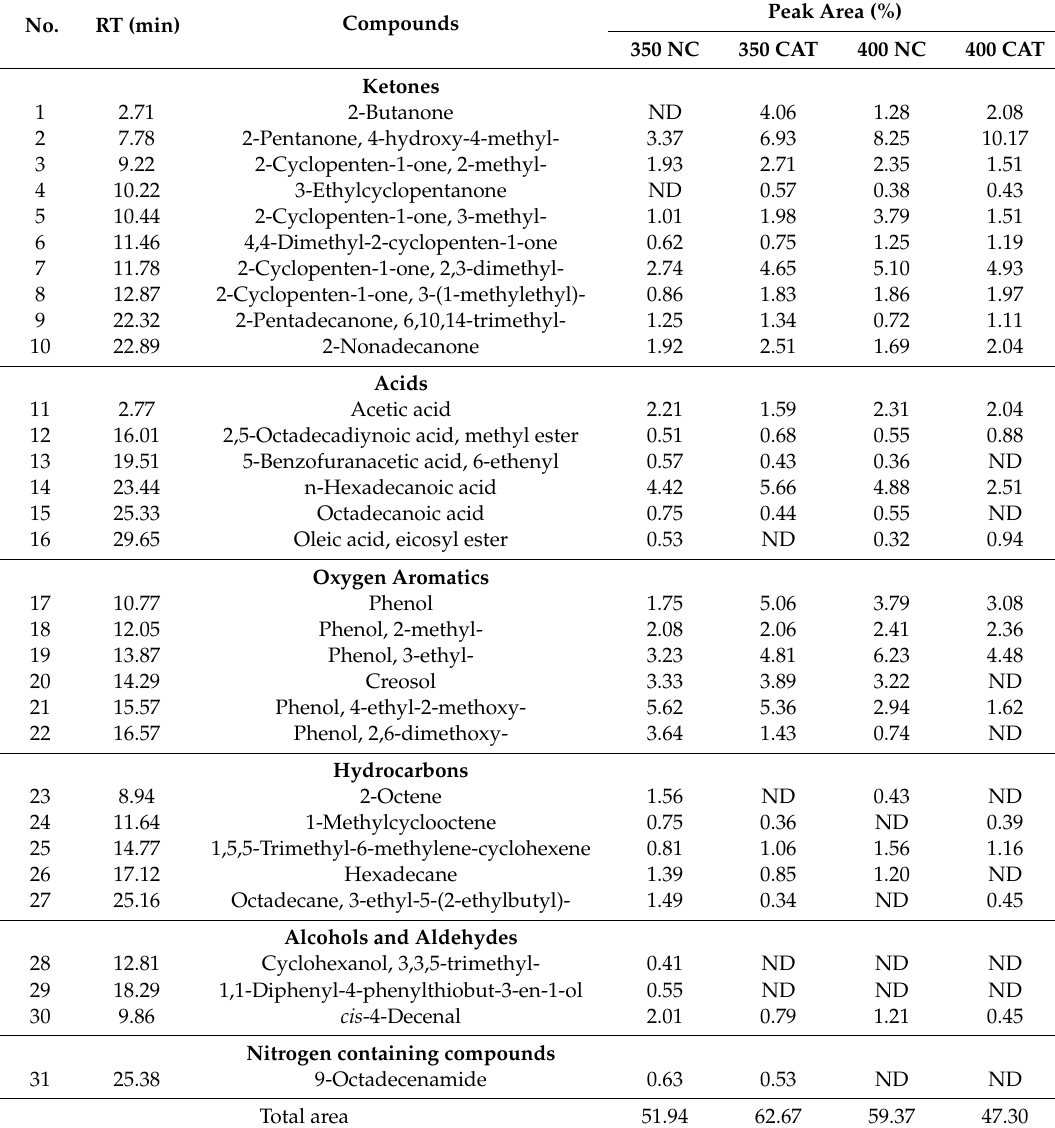
Table 3. Main chemical compounds detected in the biocrude at all four